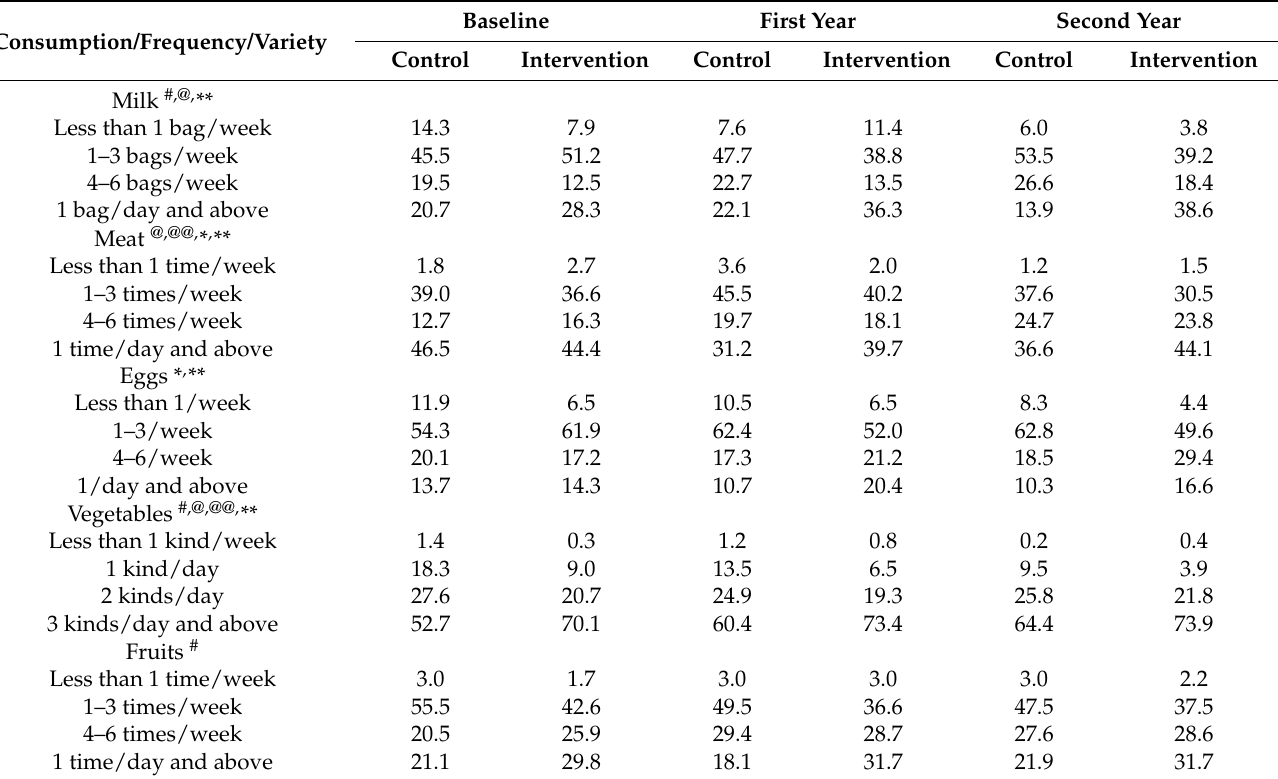
Table 5. Comparison of milk consumption; the frequency of meat, egg, and fruit consumption; and the variety of vegetables of children in the past week between the intervention group and control group